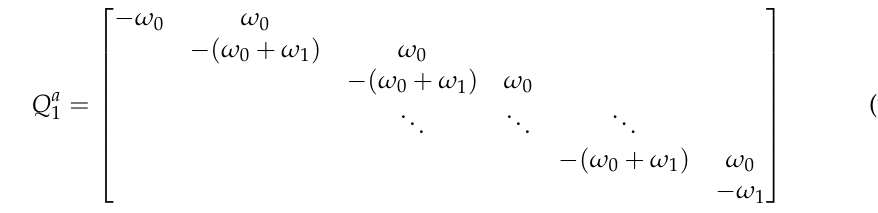
The transition rate of state ( r , b 1 ( t )) → ( r + 1, b 1 ( t + ∆ t )) is exactly the death rate ω 1